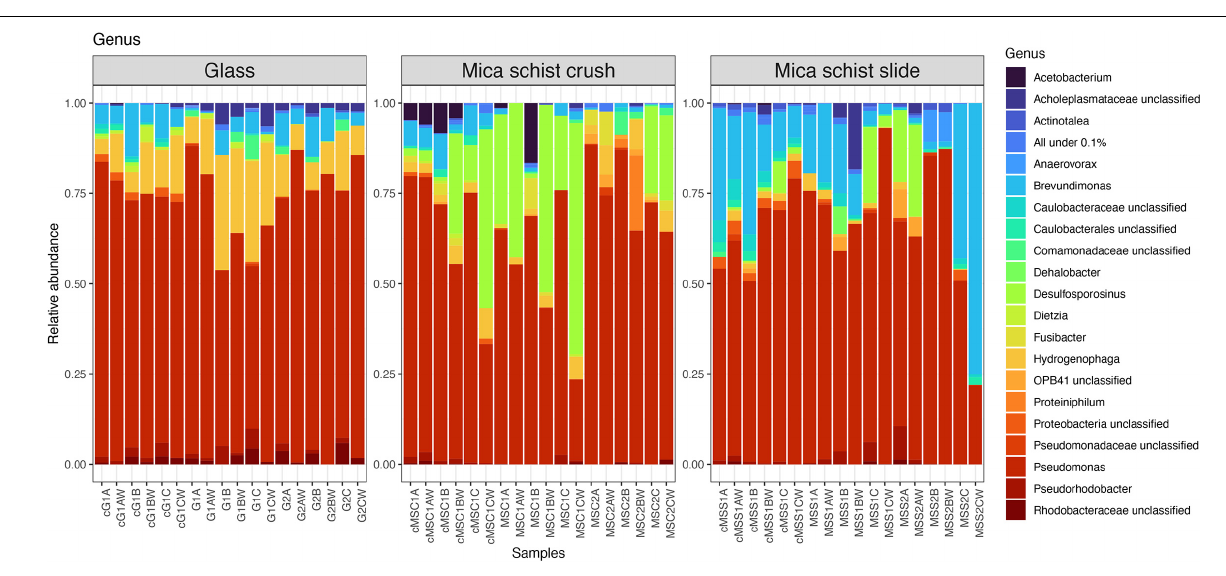
had otherwise different community composition